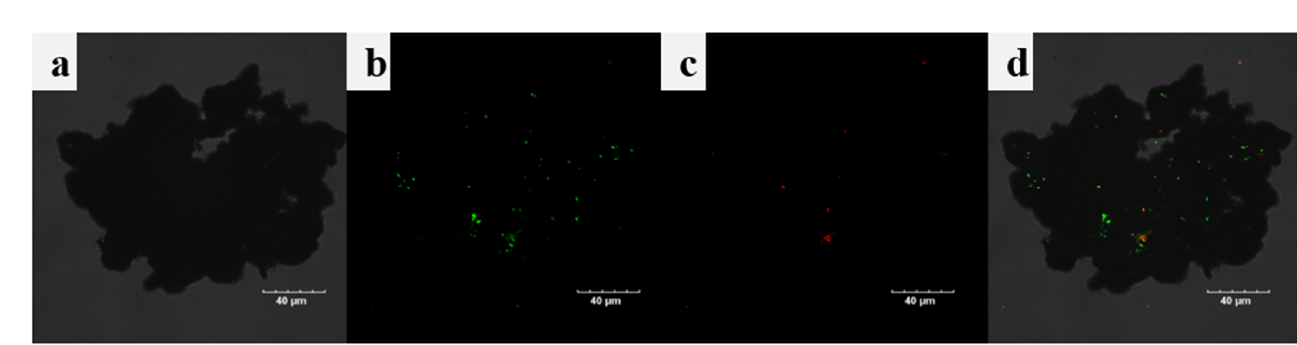
Figure 4. CLSM micrographs of the co-immobilized lipases onto mMWCNTs@4-arm-PEG-NH 2 ; ( a ) bright-field micrograph; ( b ) dark field of RhB-labeled CRL fluorescence micrograph ( c ); dark field of FITC-labeled ROL fluorescence micrograph ( d ); overlay of a bright field, RhB-labeled CRL and FITC-labeled ROL fluorescence micrograph.